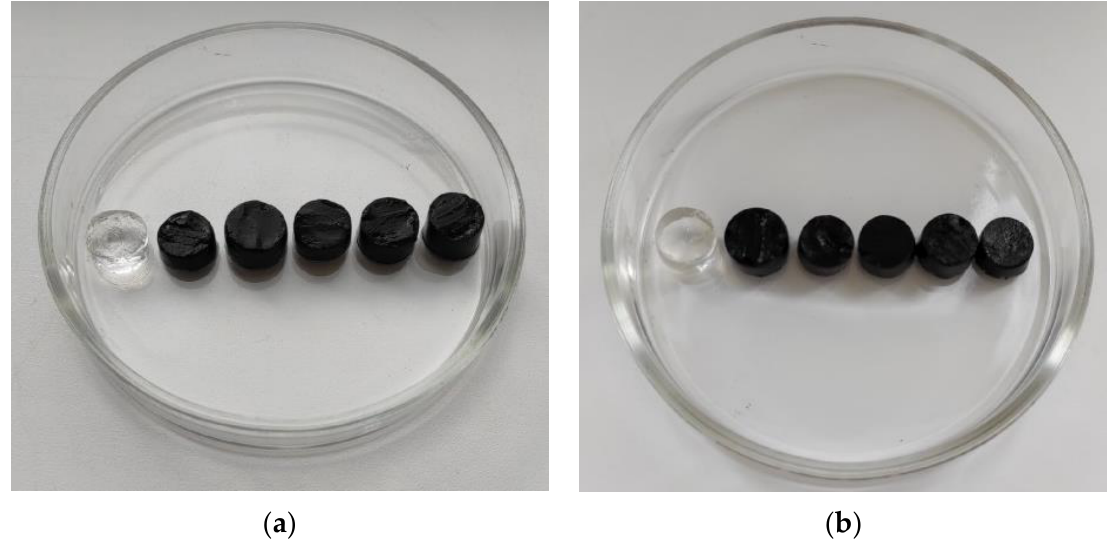
Figure 2. General view of PAAm/Xanthan ( a ) and PAAm/Guar ( b ) FGs samples filled with MPs at various weight fractions. ( a ) Weight fraction of MPs: 0.0%, 1.9%, 4.3%, 5.7%, 12.9%, 22.3%; ( b ) 0.0%, 2.9%, 4.6%, 10.3%, 16.0%, 23.3% (from the left to the right). Diameter of samples is about 13 mm.